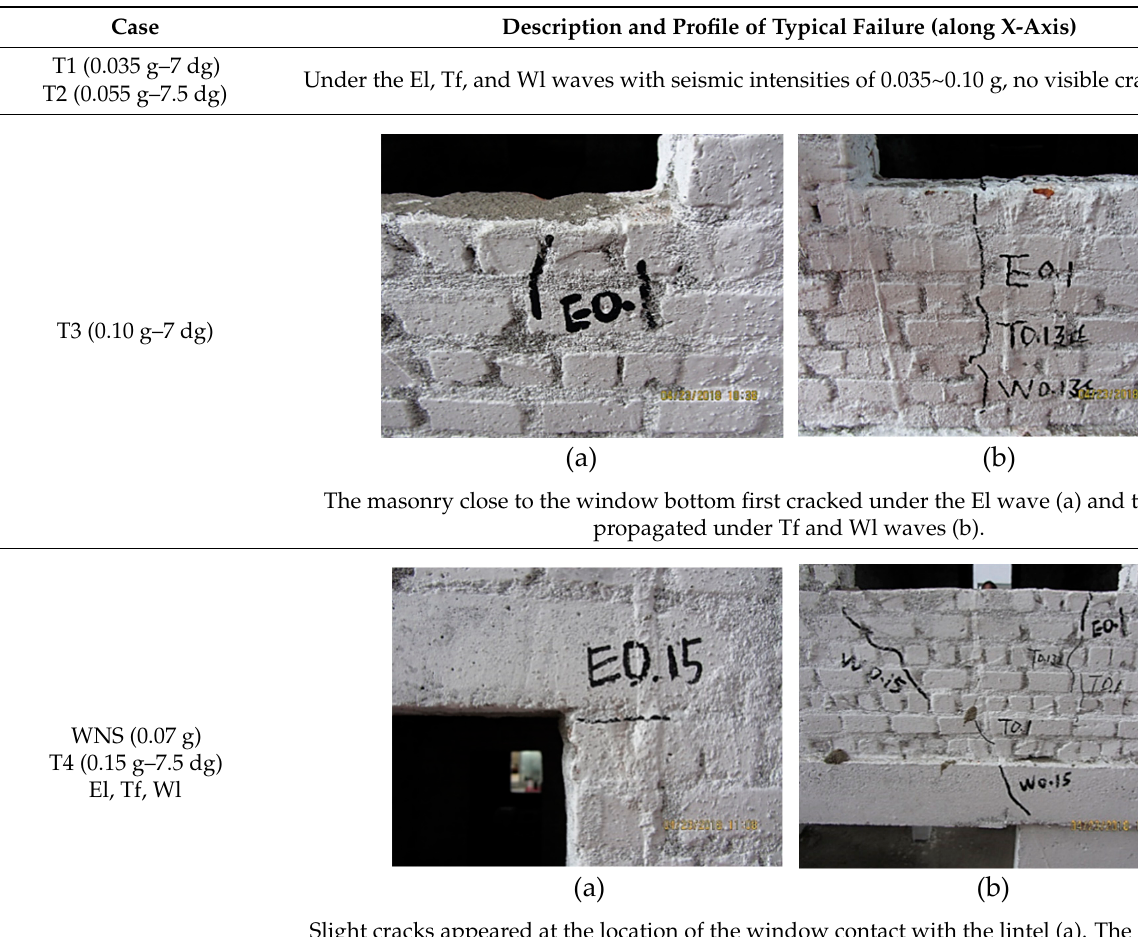
Table 5. The seismic input scheme and the failure profiles of the bottom frame